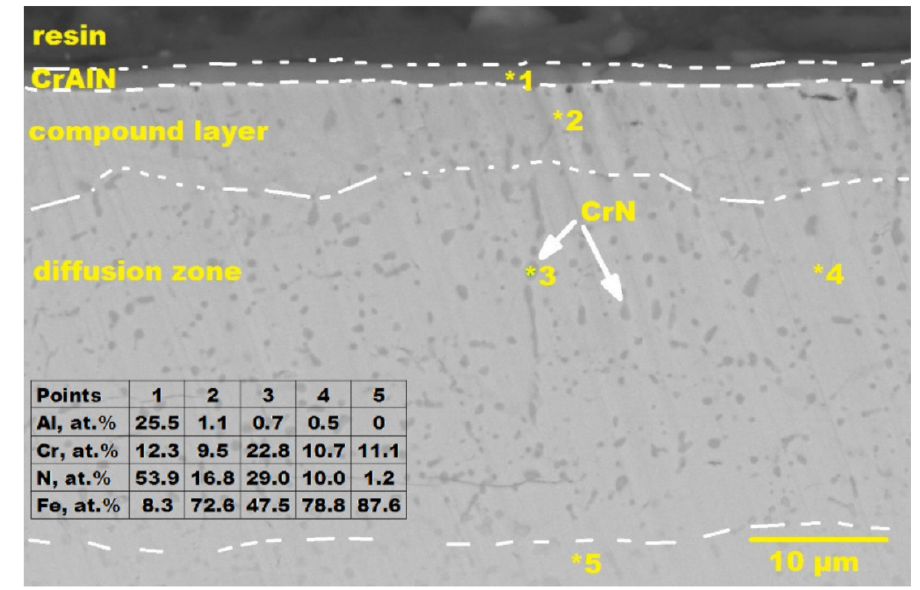
Figure 4. SEM image of the cross-section microstructure of the N40 sample and corresponding EDS data (in at.%).